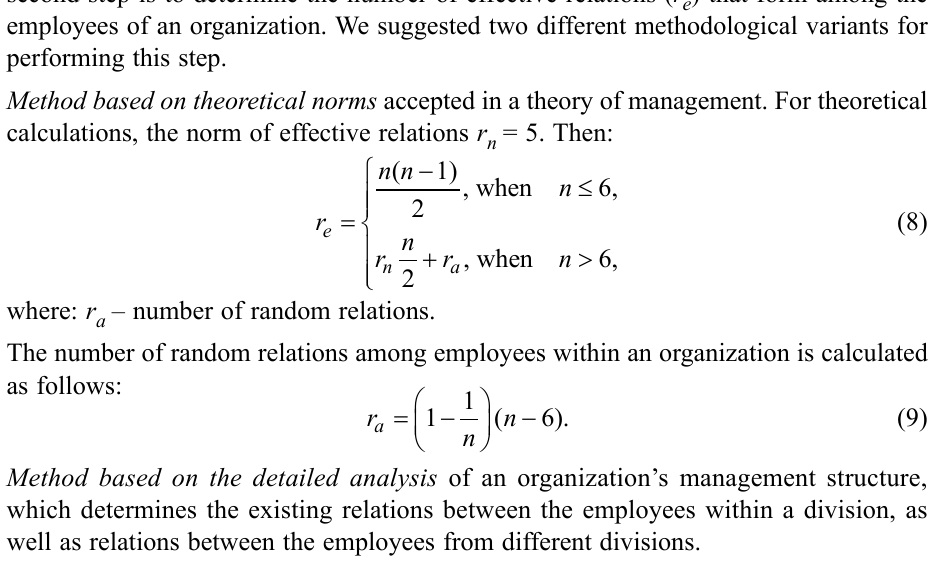
Table 3. Synthesized evaluation characteristics of factors by their importance Factors V 1 1.00 0.52 3.14 0.34113 V 1 2.14 1.00 4.29 0.54303 V 2 0.34 0.25 1.00 V 3